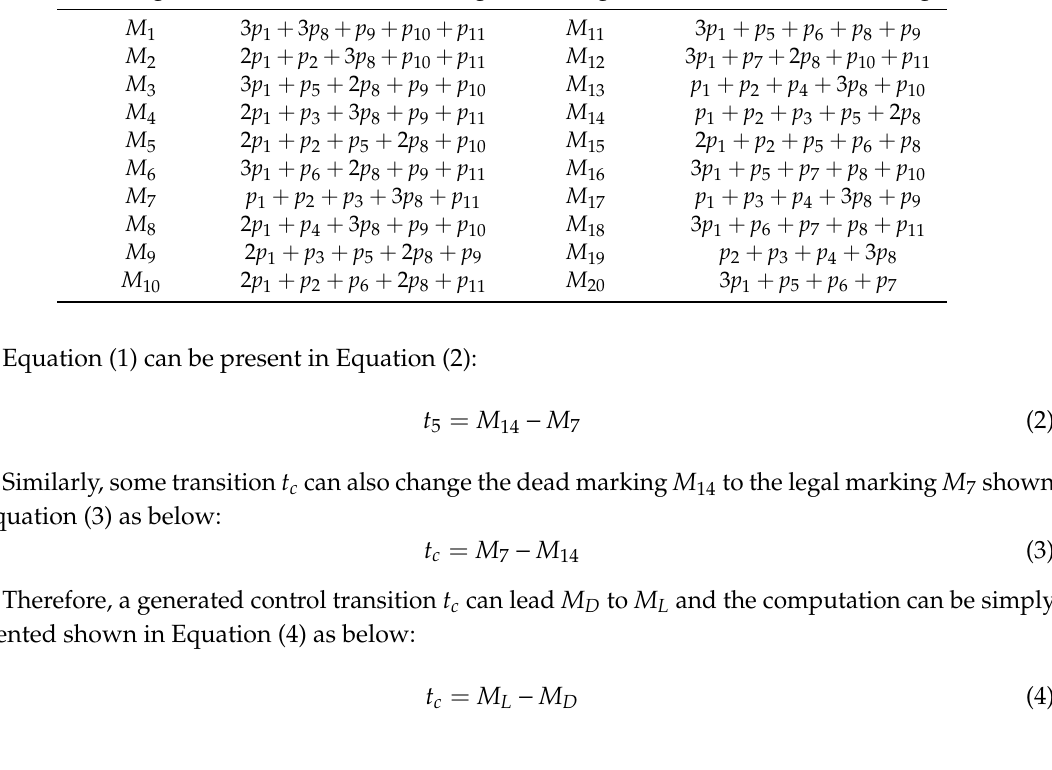
Marking No. Information of Marking Marking